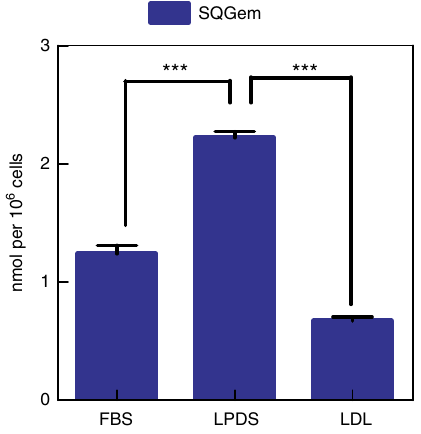
Figure 5 | 3 H-SQGem NPs cellular uptake in MDA-MB-231 cells. 3 H-SQGem NPs uptake in MDA-MB-231 cells cultured in medium supplemented with FBS, LPDS or preincubated with an excess of LDL in LPDS-supplemented medium at 37 (cid:2) C. Results are expressed as nanomoles of Gem per one million of cells (bars represents mean values ±